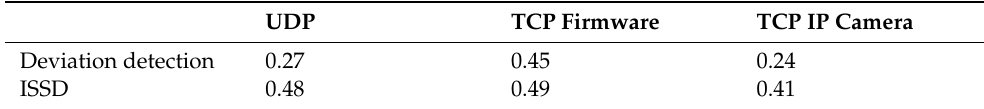
Table 11. F1 score for deviation detection and